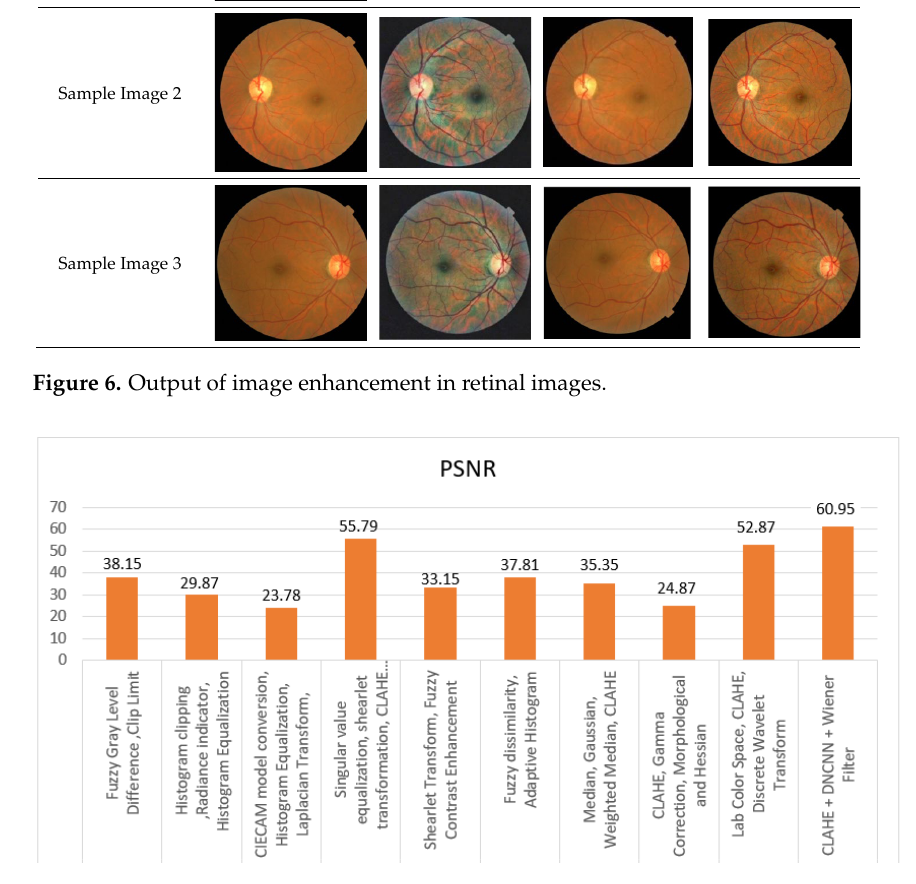
Figure 7. Graph depicting the performance of pre-processing with other methods.